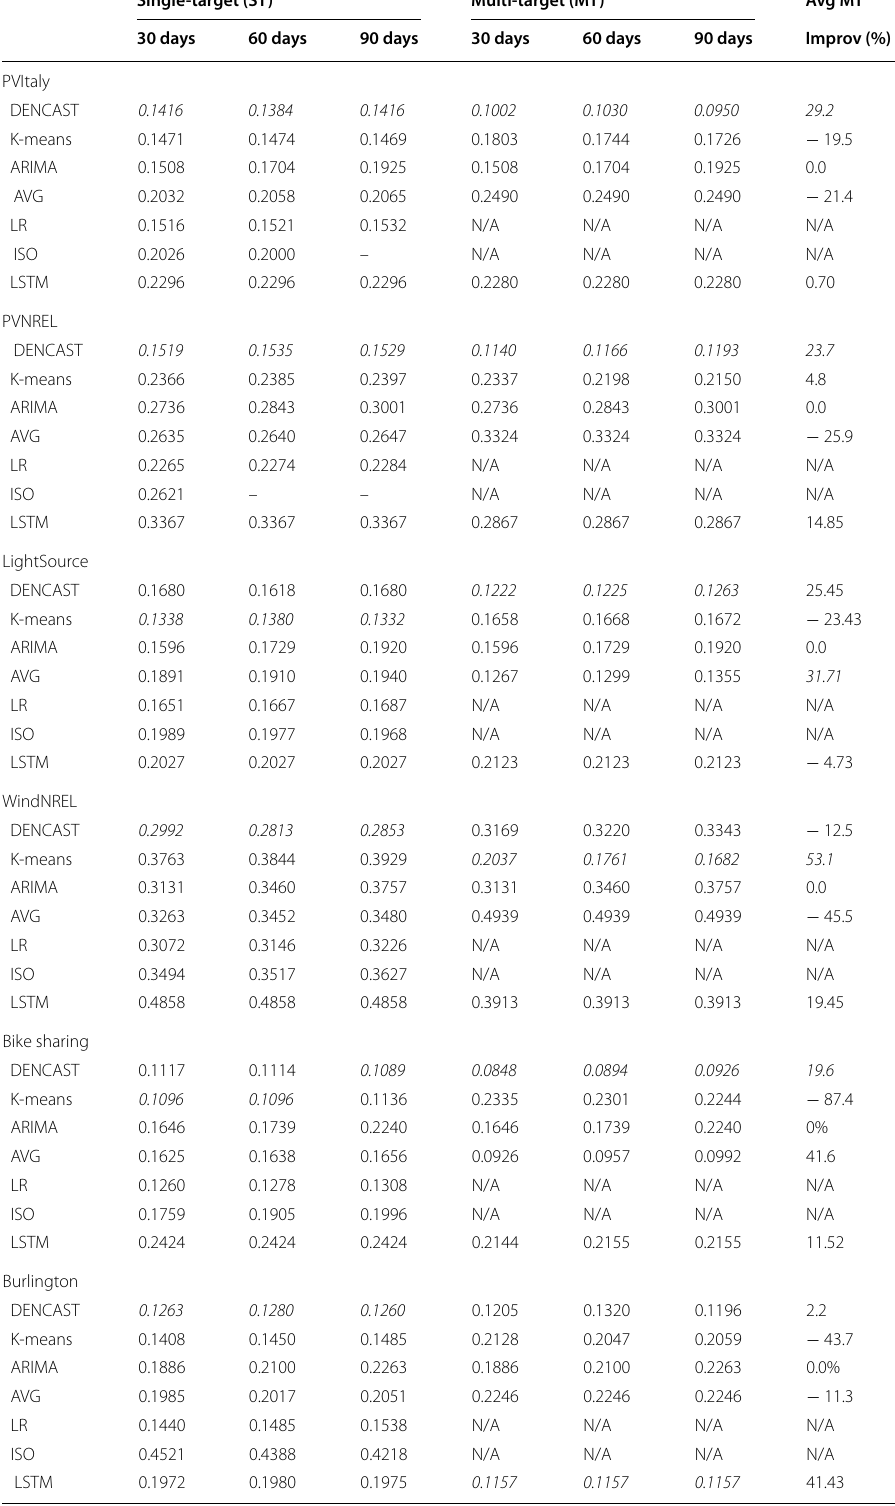
The best results for each configuration are highlighted in italics. The last column represents the improvement of MT w.r.t.